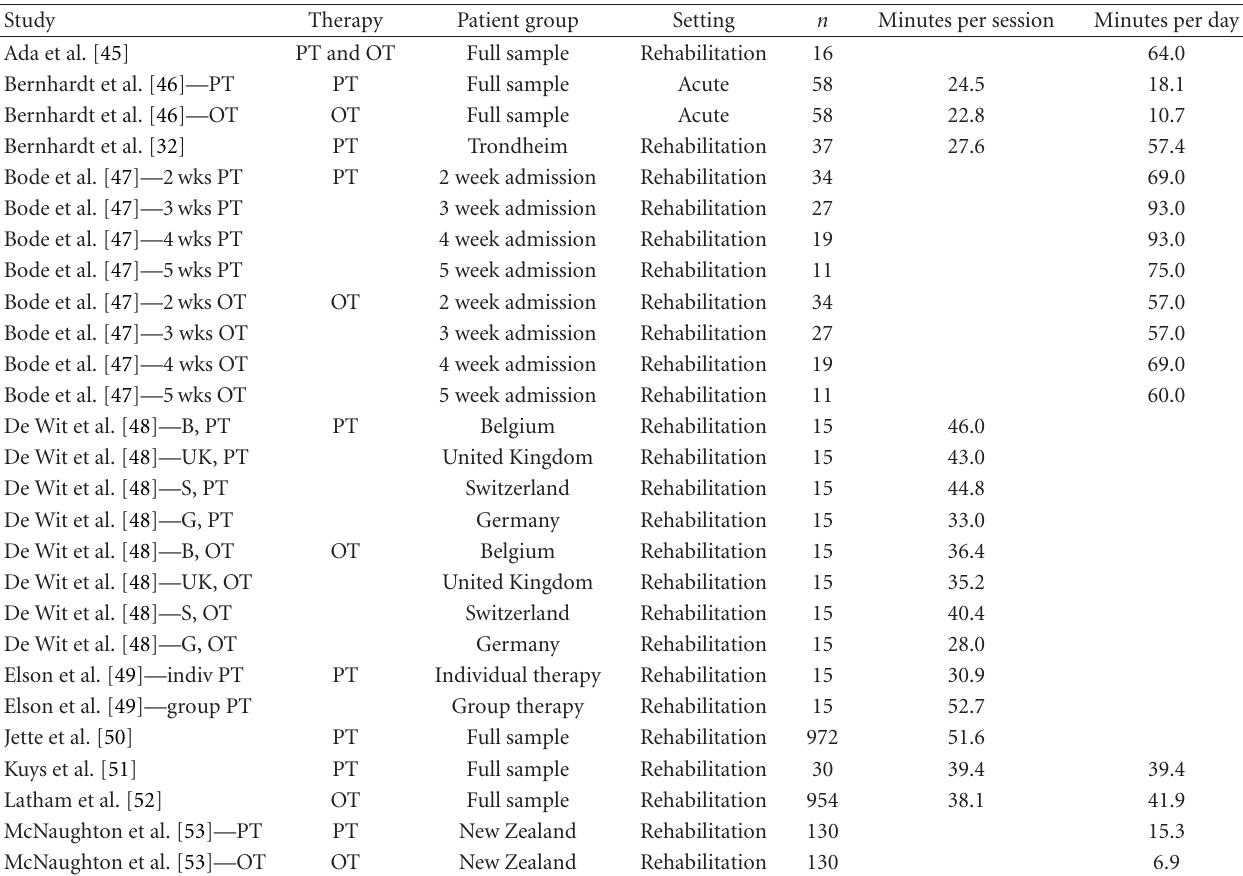
Table 4: Therapy activity patient groups and therapy